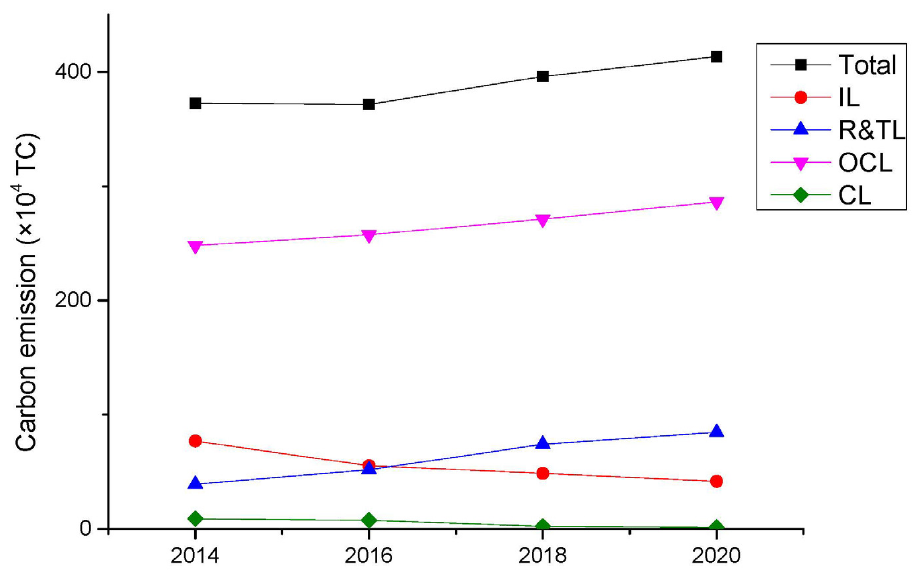
Figure 3. Total carbon emissions.